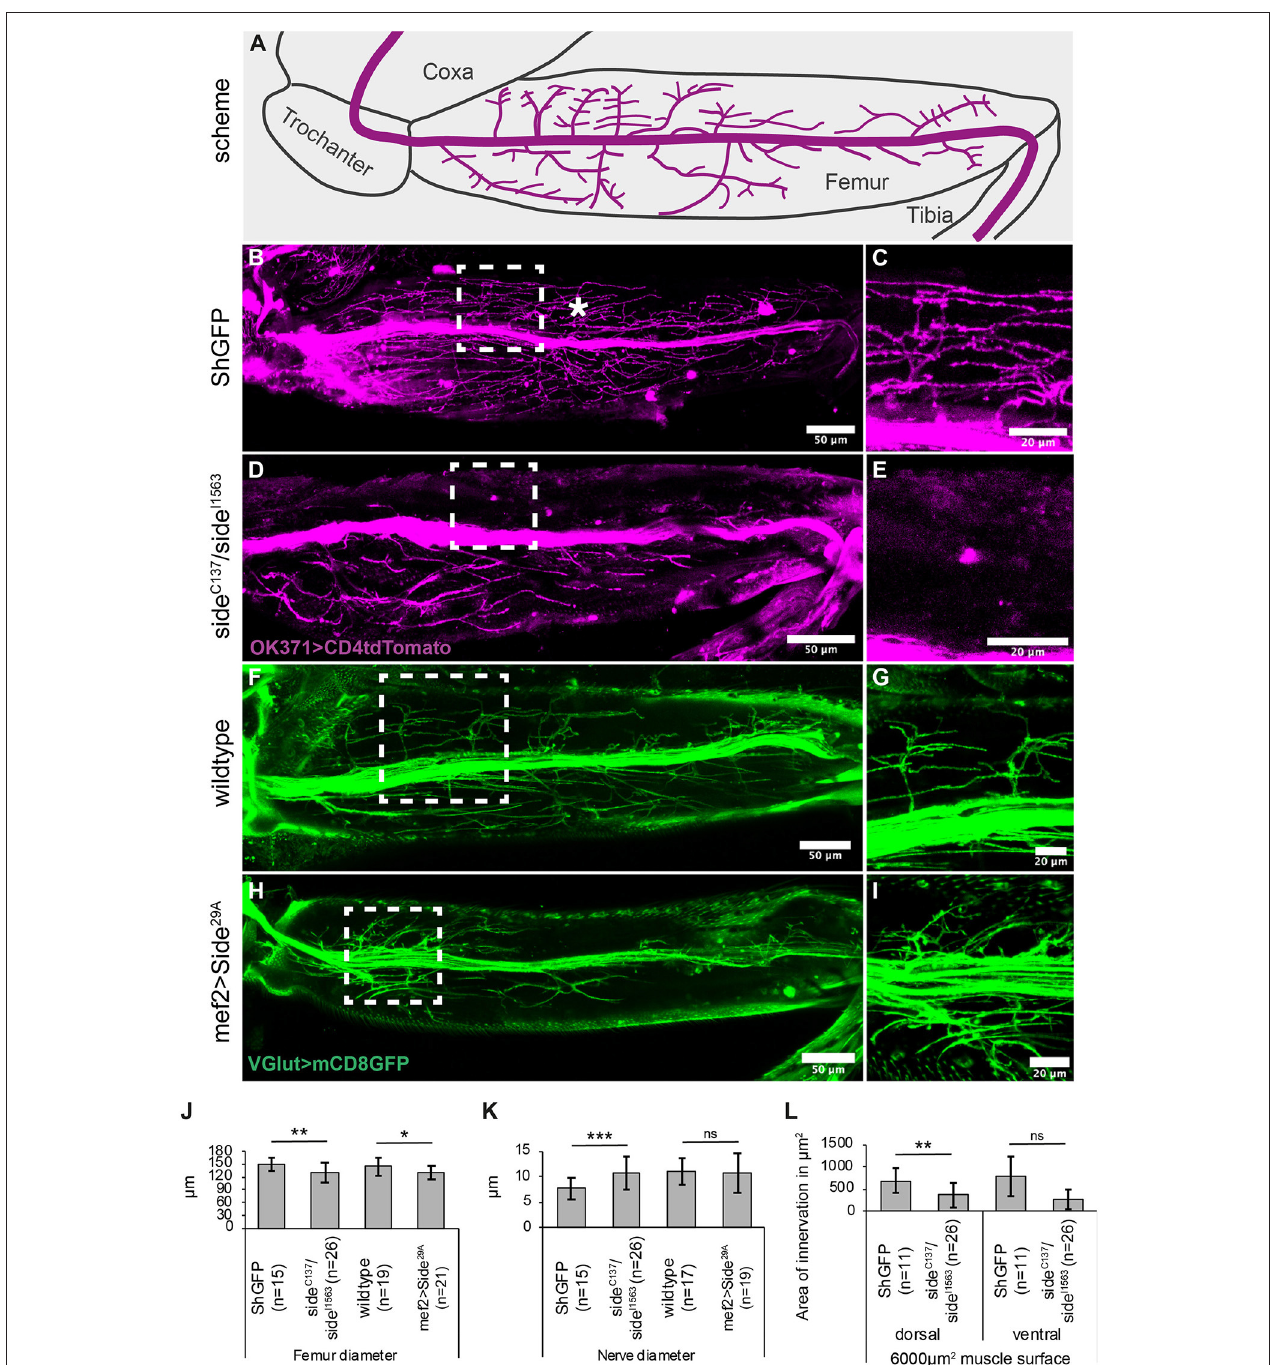
FIGURE 2 | Projection errors of leg nerves in side mutant and overexpressing Side flies. (A) Scheme of a tentative projection pattern of motor nerves (magenta) in the femur. (B,C) Confocal projections of the femur acquired through the translucent cuticle of a ShGFP control animal, expressing CD4tdTomato (magenta) under control of OK371-Gal4 in motor axons. The leg nerve forms a central bundle and sprouts numerous primary and secondary branches that evenly cover the dorsal tilm (asterisk) and ventral tidm muscles. (D,E) Homozygous side mutant pharate adults display a thicker central bundle and less branches reach the tilm muscle. (F,G) Motor axons expressing mCD8GFP (green) under the control of VGlut-LexA in a wild-type background. (H,I) Motor axons expressing mCD8GFP (green) under control of VGlut-LexA in pharate adults overexpressing Side in developing muscles using Mef2-Gal4 . Motor axons show excessive branching in proximal regions of the tilm and tidm muscles. (J–L) Quantitative analysis of femur and leg nerve diameters (J,K) and area of innervation of tilm and tidm muscles (L) in control, side mutant andoverexpressingSideflies.Femursareslightlythinner (J) andlegnervesarethicker (K) onanaveragein side mutants.DorsaltilmmusclesevaluatedbyStudent’s t -test